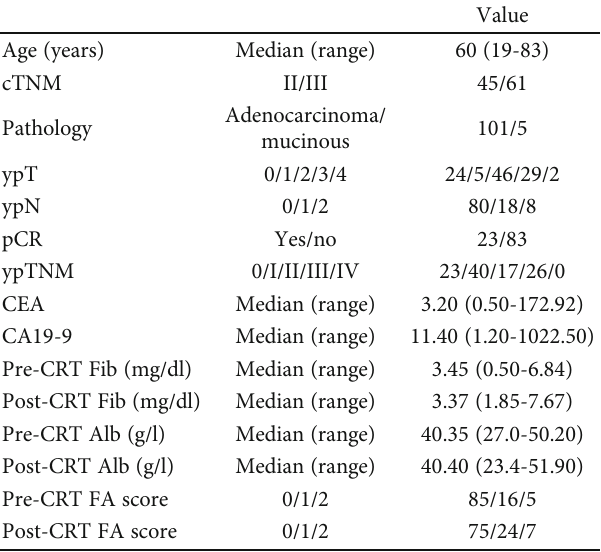
Table 1: Patient clinicopathologic characteristics. Table 2: Association between clinicopathological factors and changes in FA